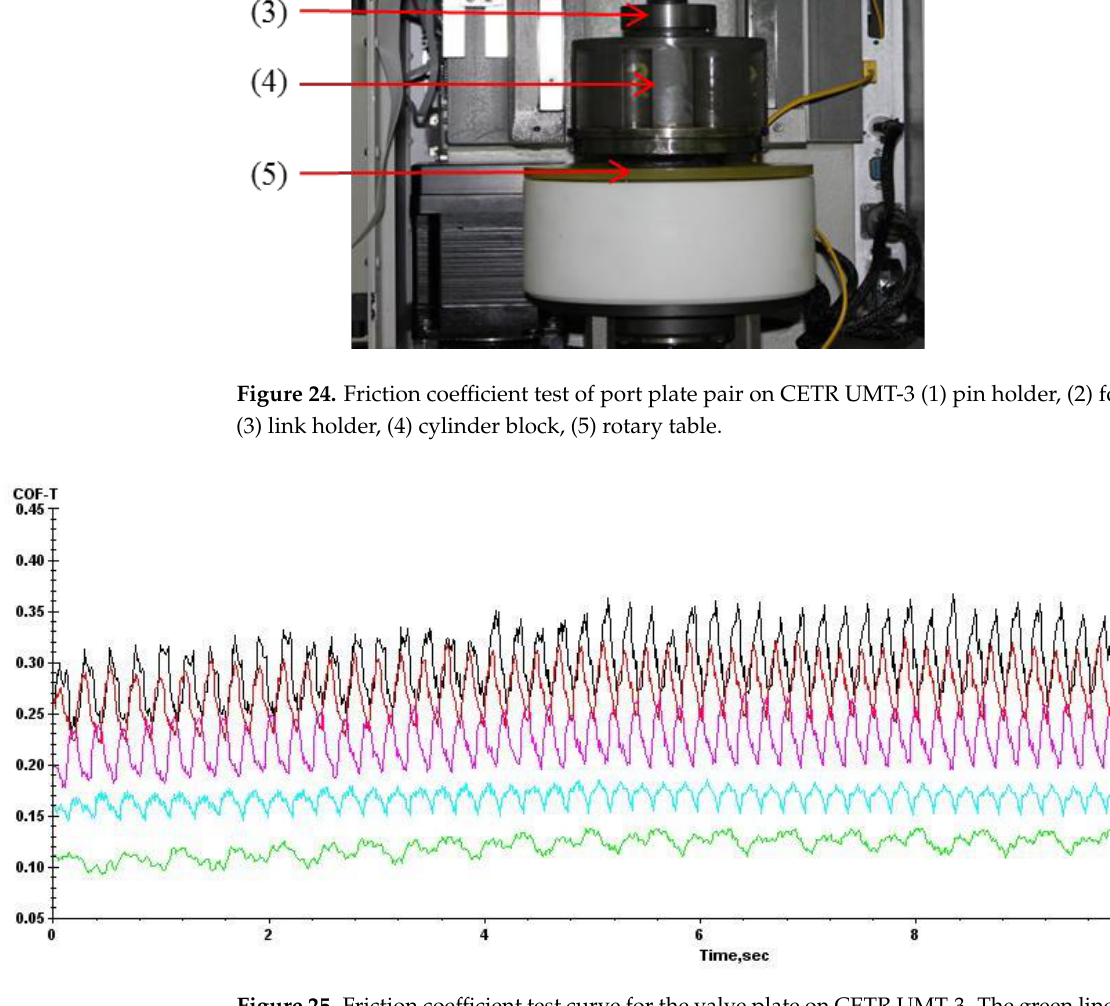
the friction coefficient under the condition of 30N. The blue line represents the friction coefficient under the condition of 50N. The purple line represents the friction coefficient under the condition of 70N. The red line represents the friction coefficient under the condition of 90N. The black line represents the friction coefficient under the condition of